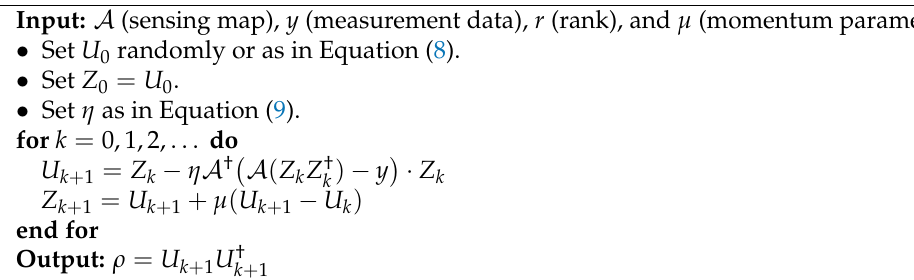
Algorithm 1 Momentum-Inspired Factored Gradient Descent ( MiFGD